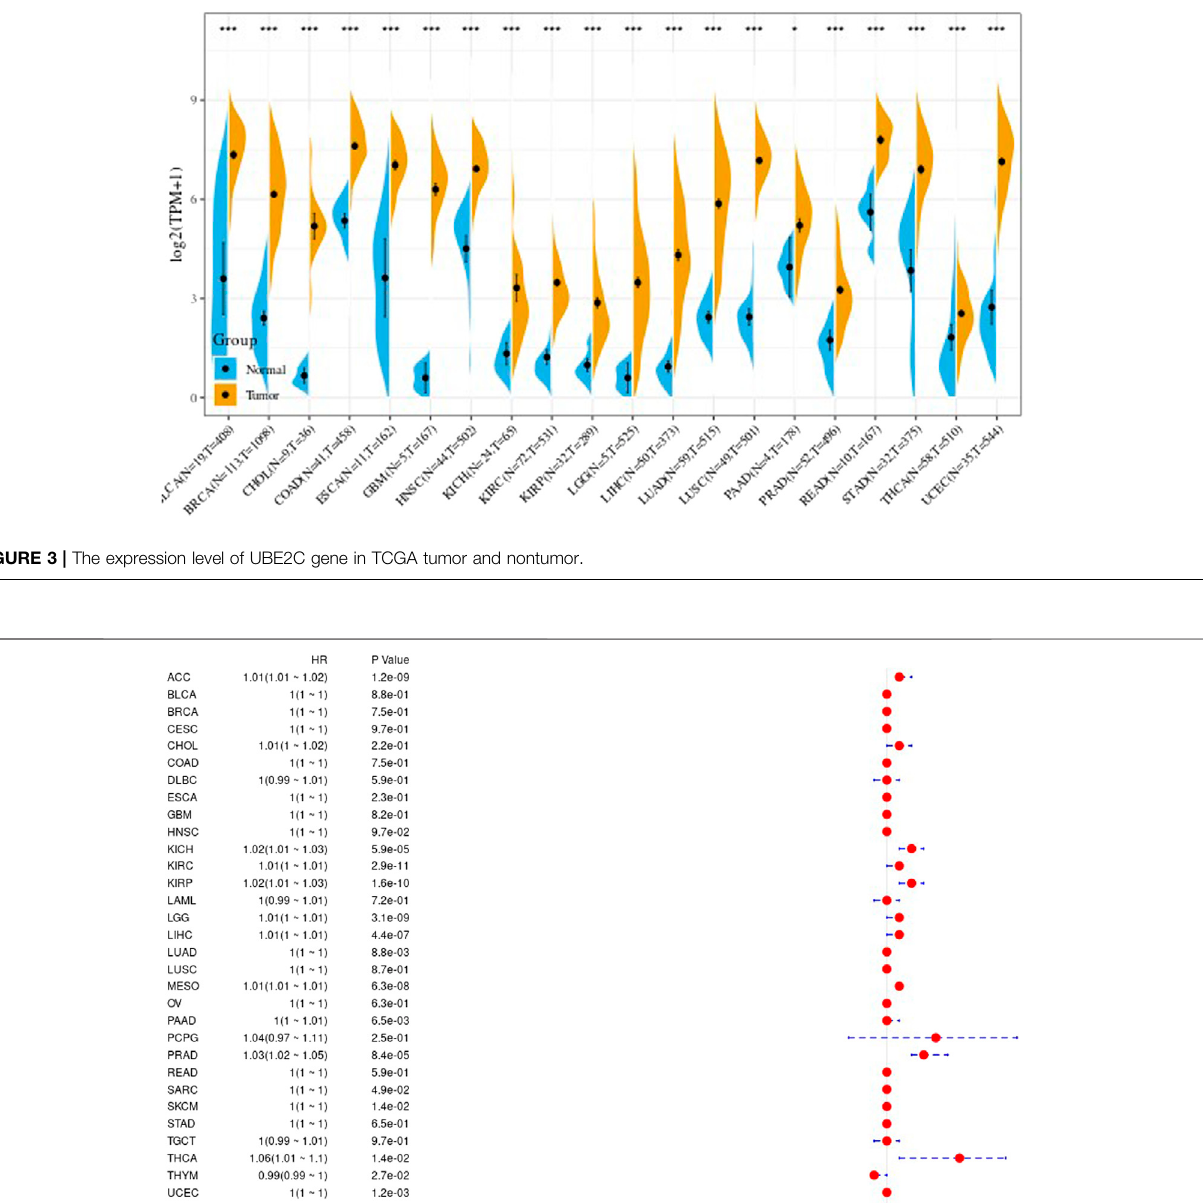
Figure S2 . The corresponding prognostic K-M curve results are shown in Figure 5 .